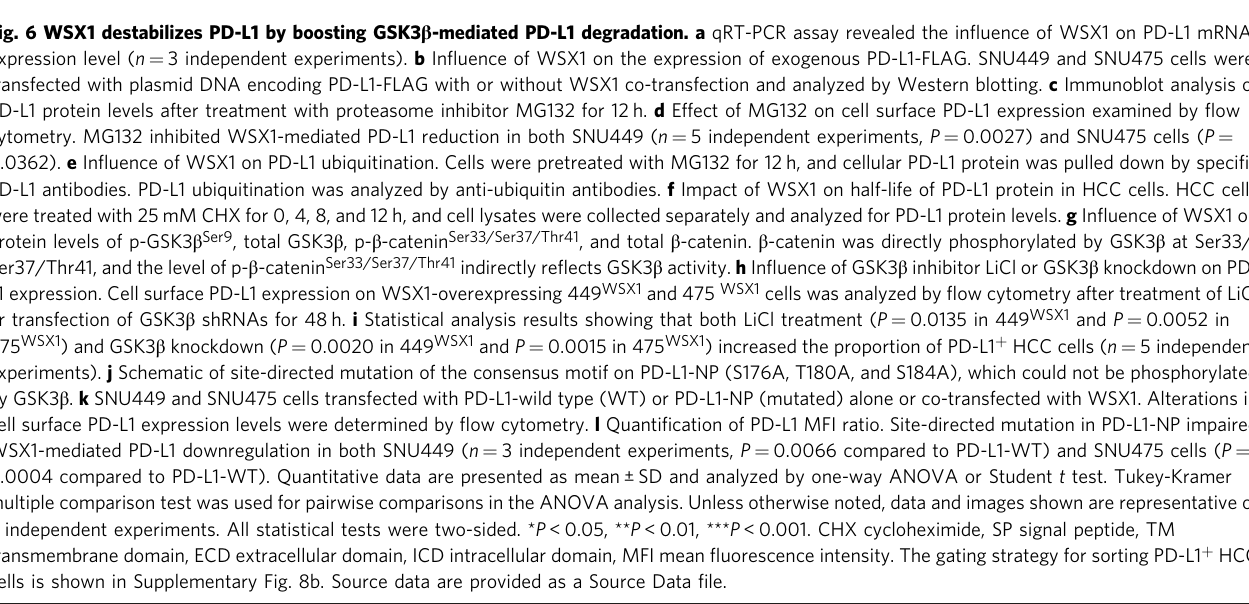
Fig. 6 WSX1 destabilizes PD-L1 by boosting GSK3 β -mediated PD-L1 degradation. a qRT-PCR assay revealed the in fl uence of WSX1 on PD-L1 mRNA expression level ( n = 3 independent experiments). b In fl uence of WSX1 on the expression of exogenous PD-L1-FLAG. SNU449 and SNU475 cells were transfected with plasmid DNA encoding PD-L1-FLAG with or without WSX1 co-transfection and analyzed by Western blotting. c Immunoblot analysis of PD-L1 protein levels after treatment with proteasome inhibitor MG132 for 12 h. d Effect of MG132 on cell surface PD-L1 expression examined by fl ow cytometry. MG132 inhibited WSX1-mediated PD-L1 reduction in both SNU449 ( n = 5 independent experiments, P = 0.0027) and SNU475 cells ( P = 0.0362). e In fl uence of WSX1 on PD-L1 ubiquitination. Cells were pretreated with MG132 for 12 h, and cellular PD-L1 protein was pulled down by speci fi